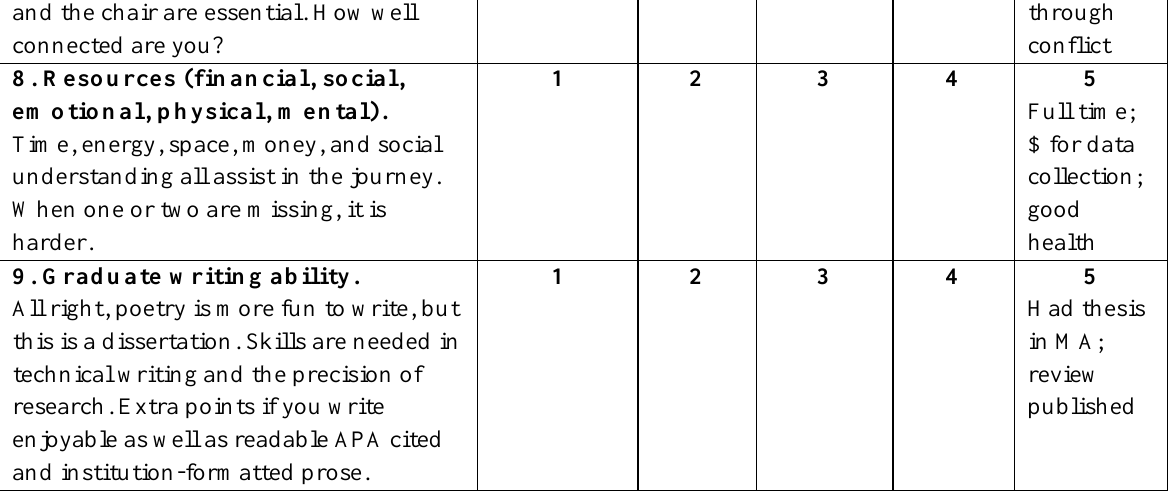
Figure 1 . Dissertation proposal readiness